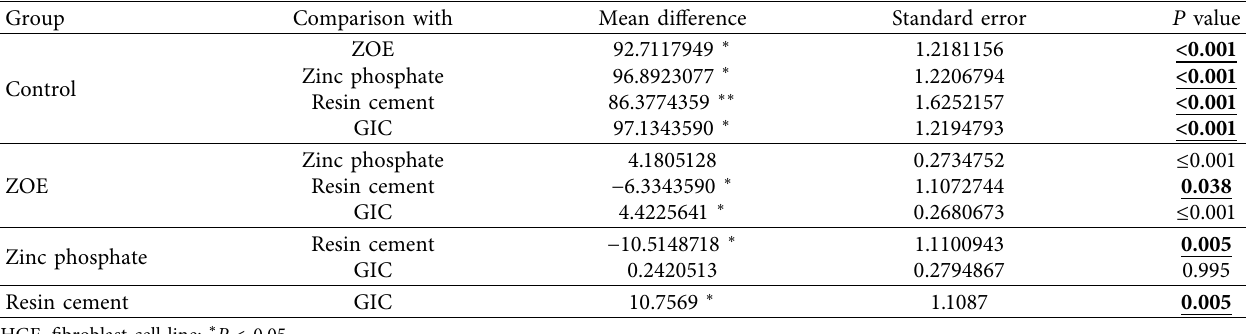
Table 3: Intergroup comparison of HGF mean cell count after 24-hour direct contact exposure to various dental cement materials using post hoc Tukey test.